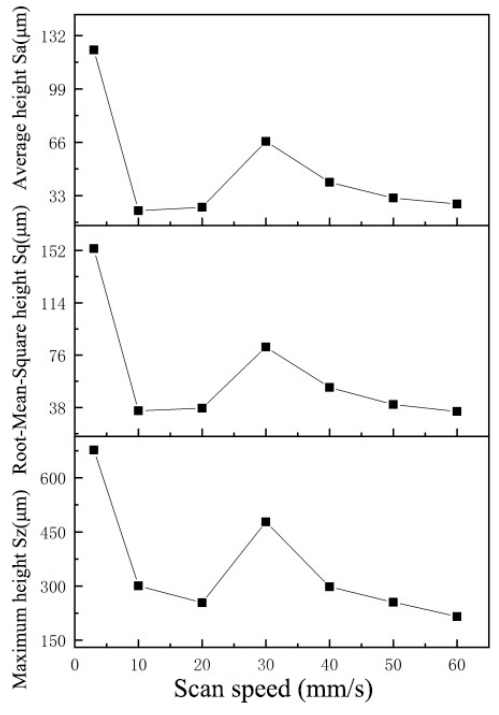
Figure 6. Surface topography parameters of the nitride layer in Figure 2b.